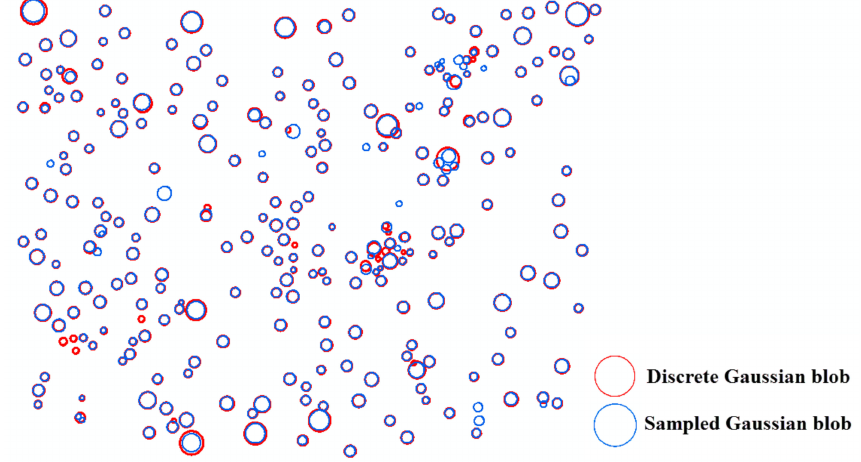
Figure 12. Di ff erences between sampled and discrete Gaussian scale-space blob detection for vitellaria